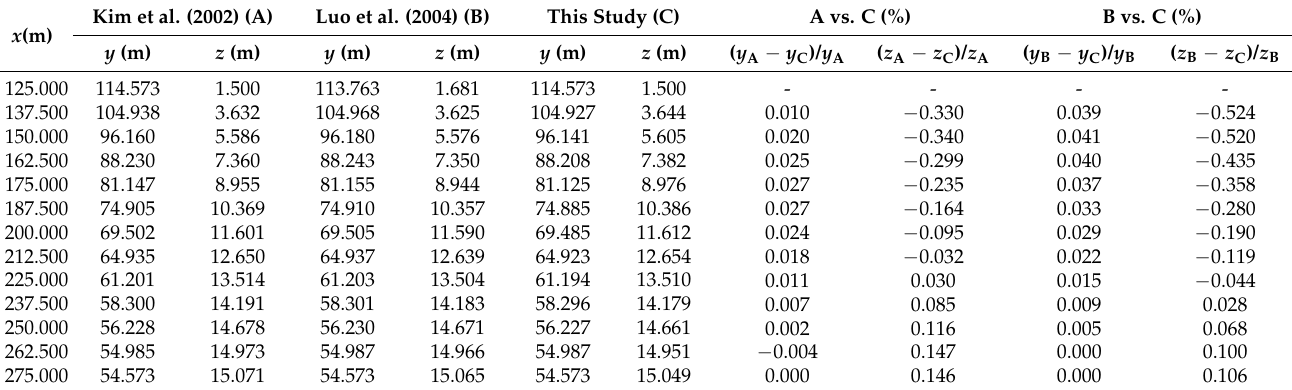
Figure 16. Outer-layer and inner-layer iteration results for 3D spatial main cables in Case 3. Table 3. Comparison between the results in this study and other